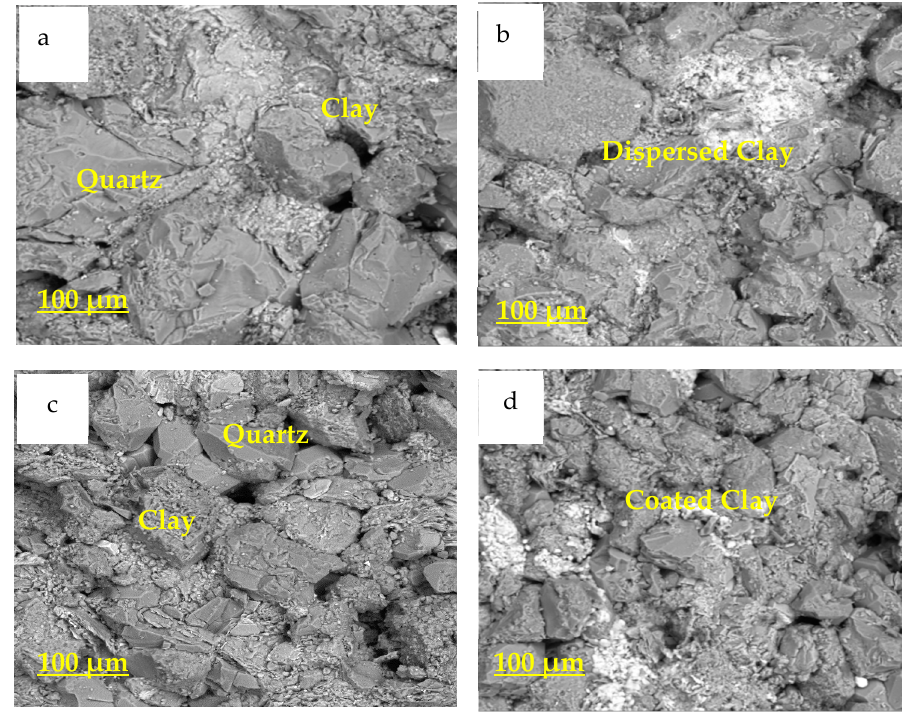
Figure 4. SEM images of ( a ) Berea before flooding ( b ) Berea after flooding: pore filling dispersed clay (illite/kaolinite based on the XRD) ( c ) Bandera Gray before flooding ( d ) Bandera Gray after flooding, quartz-grain-coated structural clay (mostly chlorite based on the XRD).